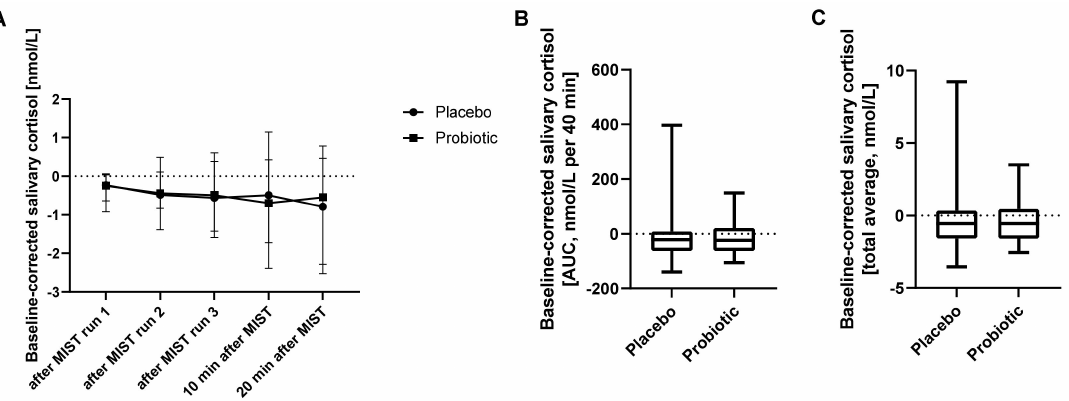
Figure 4. Salivary cortisol concentration during MIST. ( A ) Baseline-corrected salivary cortisol concen- tration during and after MIST. ANOVA, n = 21, median with interquartile range. ( B ) Salivary cortisol as area under the curve (AUC) and ( C ) as total average. Line presents median, box presents 25th and 75th percentile, and whiskers present minimum to maximum. Wilcoxon matched-pairs signed rank test, n = 21.